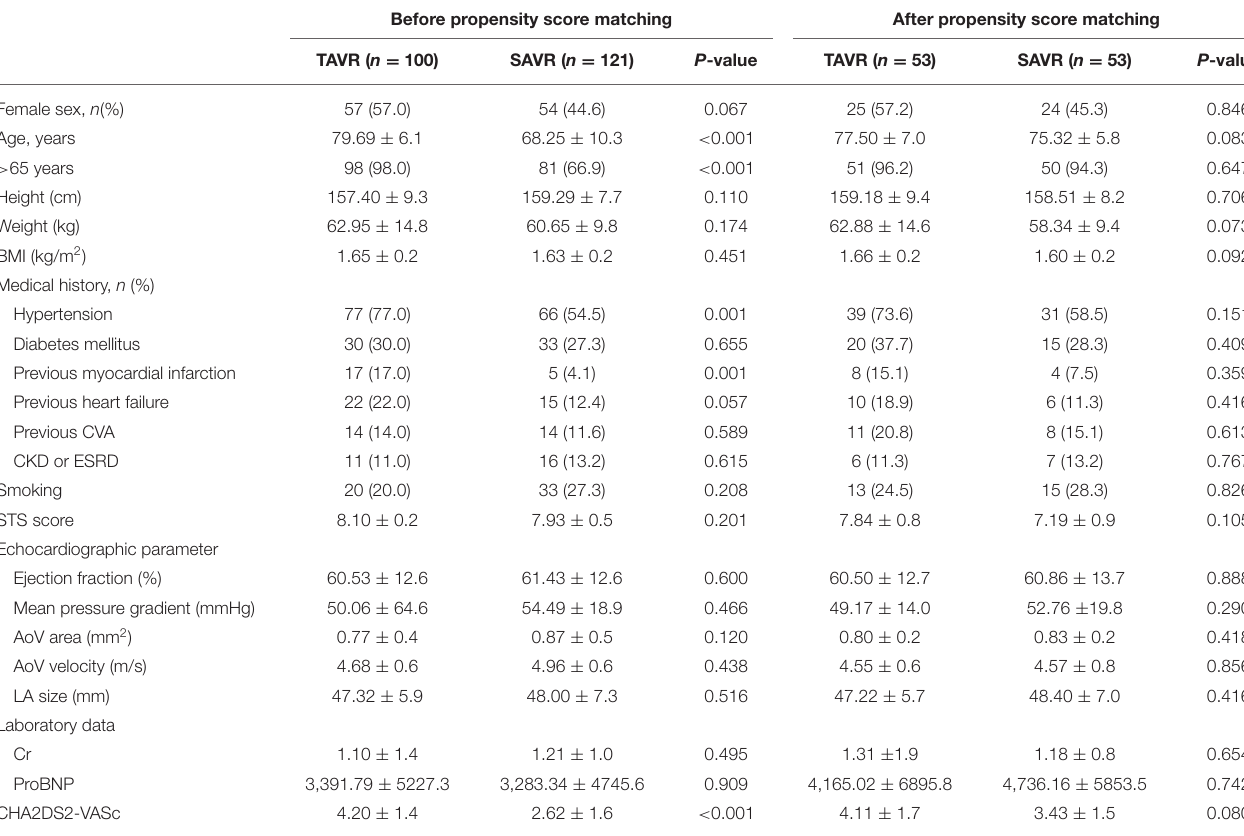
TABLE 1 | Baseline characteristics before and after propensity score matching. Before propensity score matching After propensity score